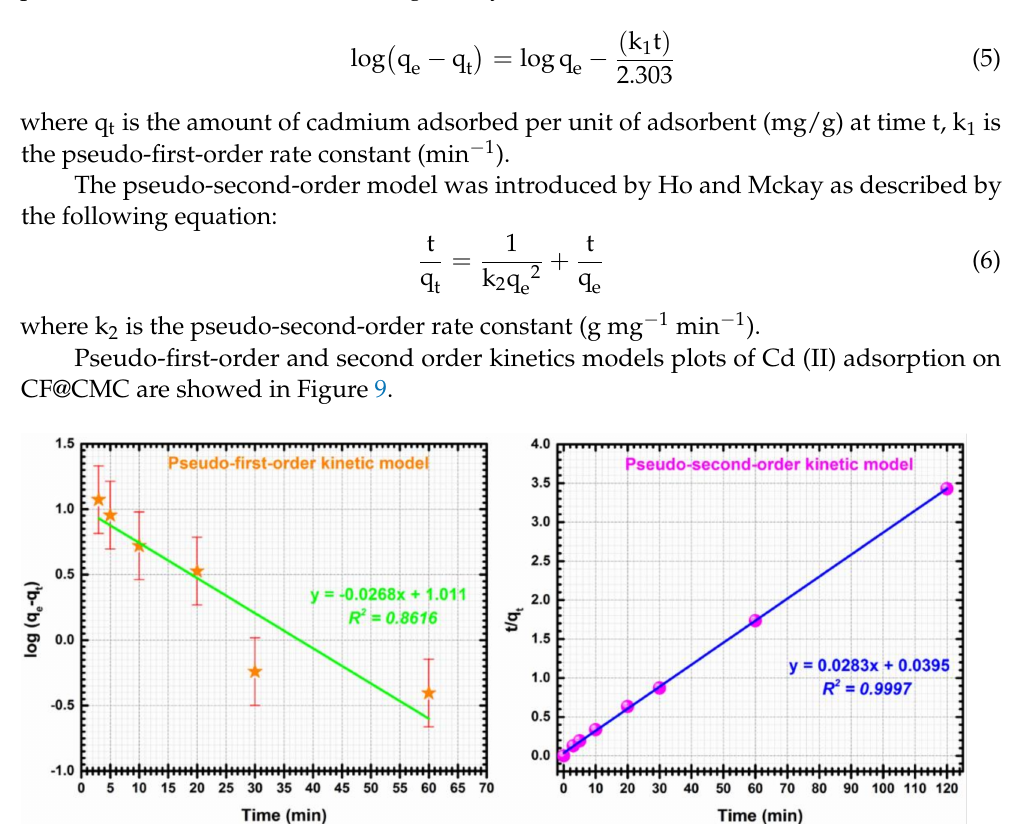
Figure 9. Pseudo-first-order kinetic ( left ), Pseudo-second-order kinetic ( right ) for adsorption of Cd (II) by